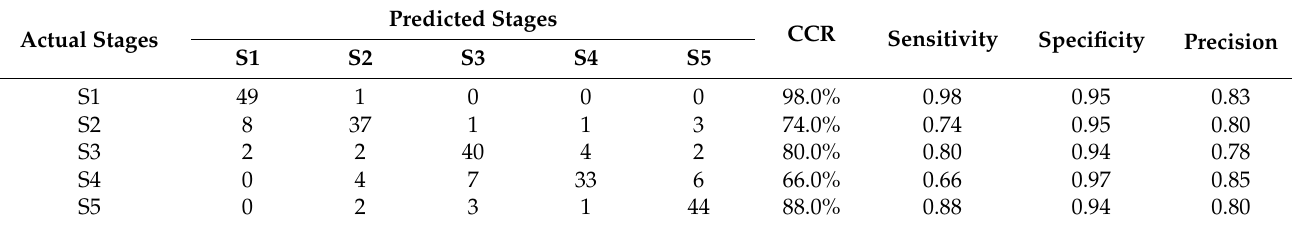
Table 5. Confusion matrix of prediction set for UVE-SPA-PLS-DA